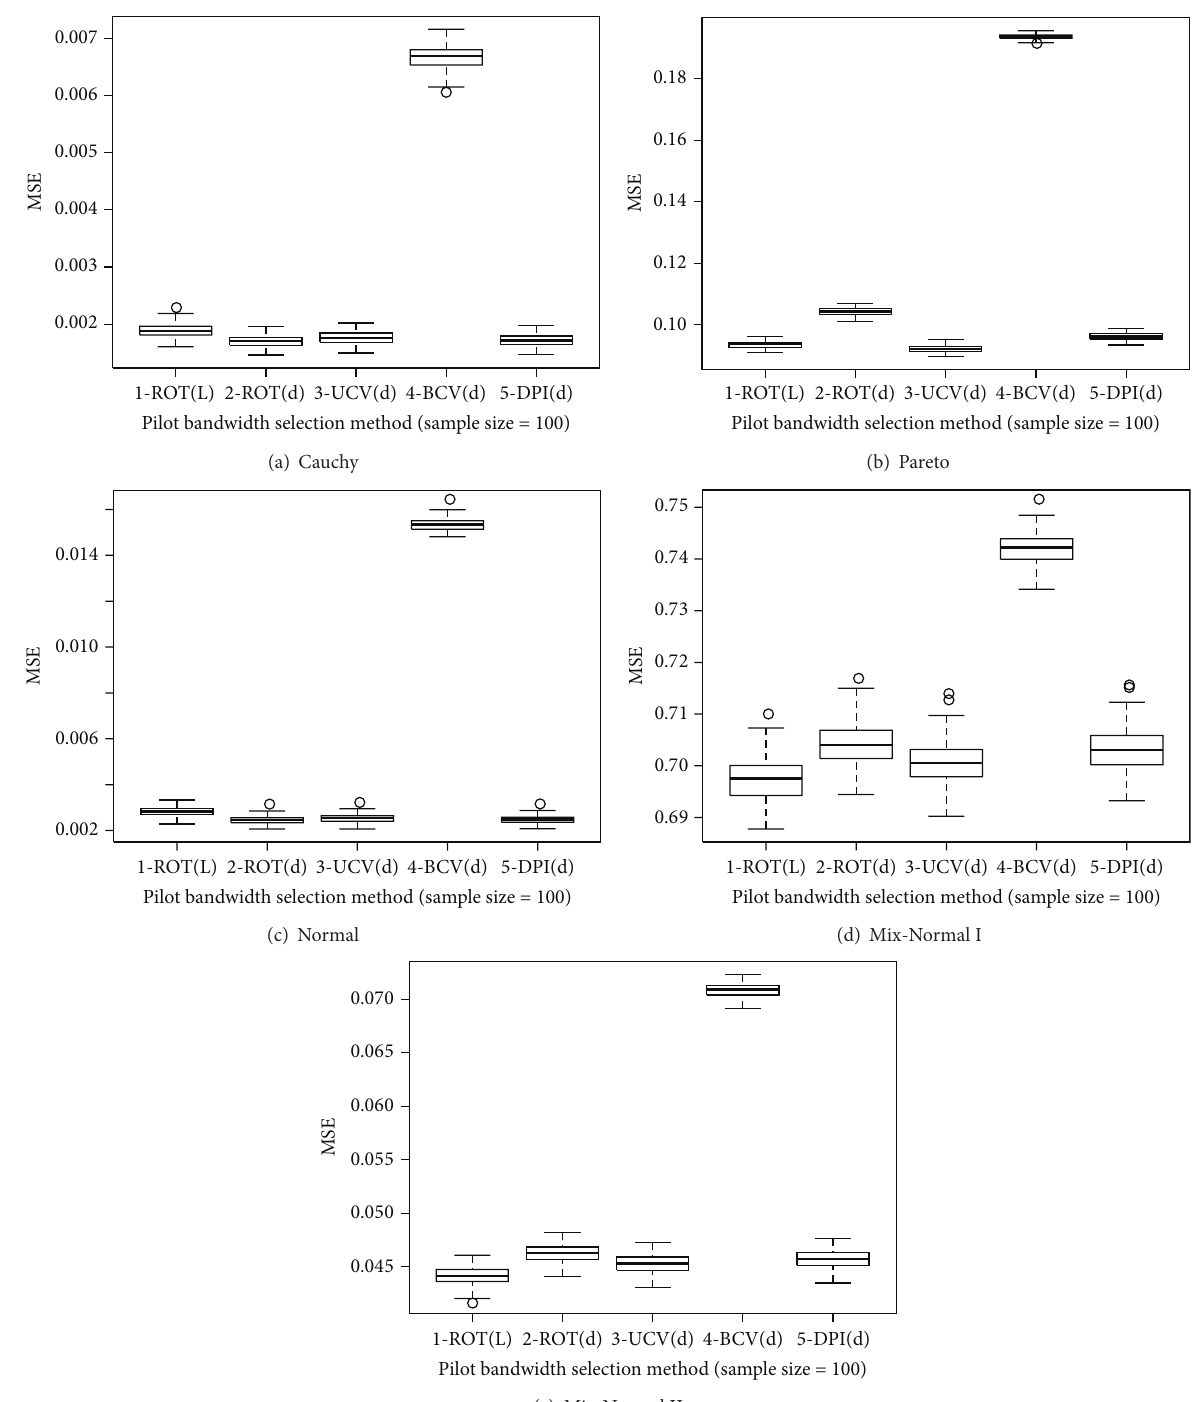
̂𝑈 2 in terms of the choice of pilot bandwidth ; “4-BCV(d)” means ̂𝑔 LSCV ; density